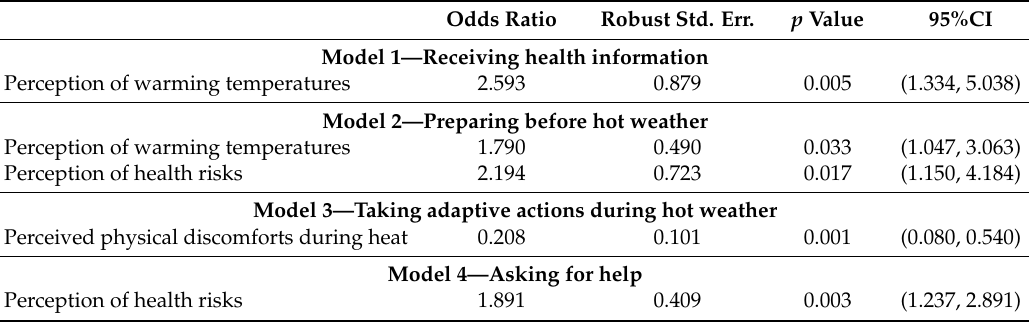
Table 4. Logistic regression models for the coping behaviors with ORs of the factors. Odds Ratio Robust Std.